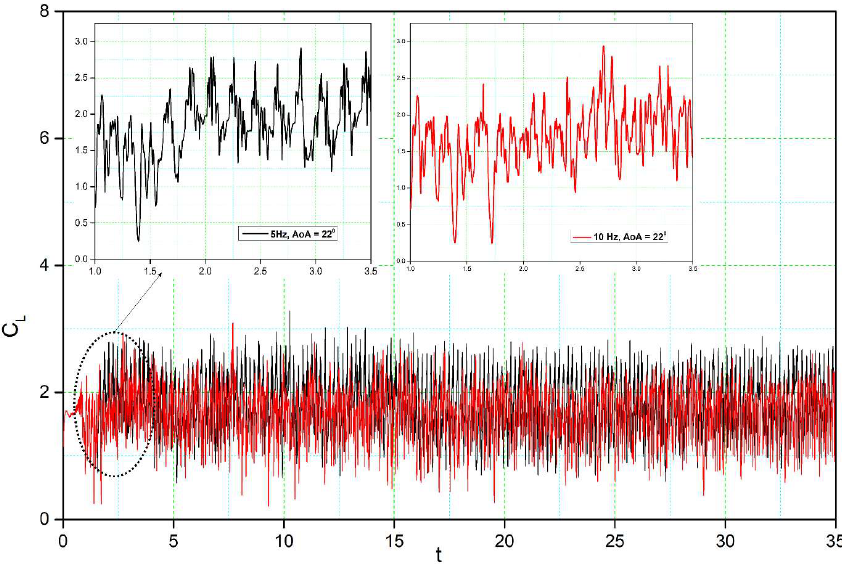
Figure 15. Lift coefficient transient responses for DMLE airfoil at 5 Hz and 10 Hz.